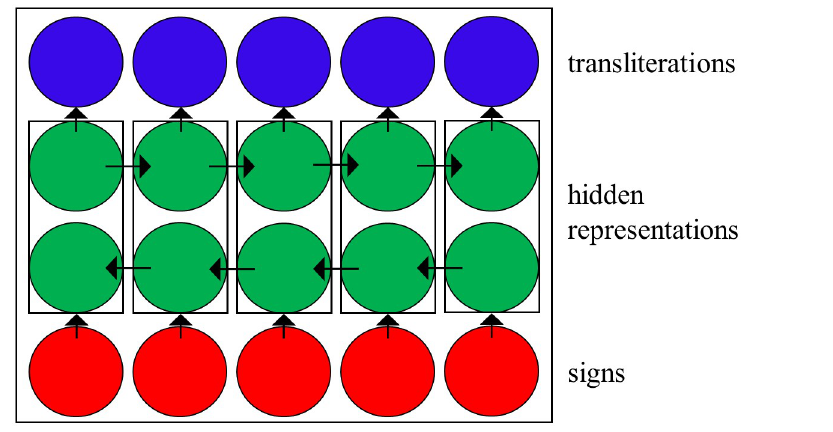
Fig 3. An illustration of the bidirectional LSTM.